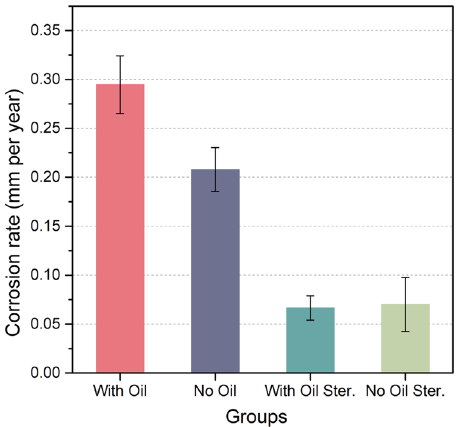
Fig. 2 The corrosion rate of steel after 85 days immersion in seawater with/without crude oil by weight loss measurements. “ With Oil ” : With crude oil amendment; “ No Oil ” : Without crude oil; “ With Oil Ster. ” : Sterilized control with crude oil amendment; “ No Oil Ster. ” : Sterilized control without crude oil. Error bars represent standard deviations of four independent steel plates.